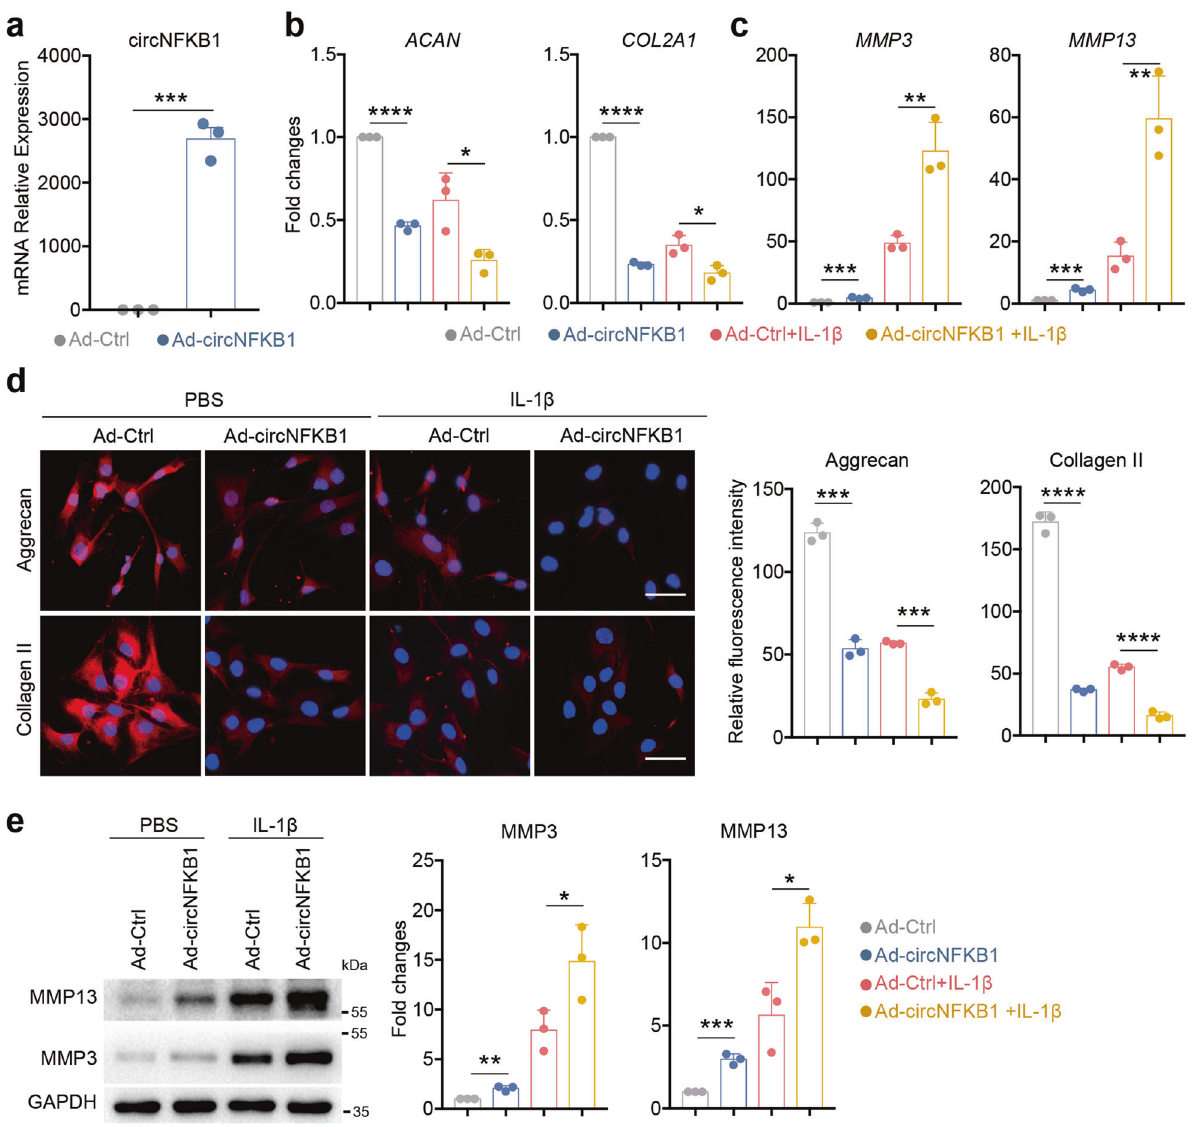
Fig. 4 Overexpression of circNFKB1 initiates ECM catabolism and promotes IL-1 β -induced chondrocytes degradation. a qRT-PCR analysis showing circNFKB1 RNA levels in circNFKB1 overexpressed HCs. b , c qRT-PCR analysis mRNA levels of ACAN , COL2A1 , MMP3, and MMP13 in circNFKB1 overexpressed HCs. d Representative immuno fl uorescence images and quantitative data of Aggrecan and Collagen II protein levels in chondrocytes after circNFKB1 overexpression. Scale bars, 25 μ m. e Western blotting analysis of MMP3 and MMP13 expression in circNFKB1 overexpressed chondrocytes. a – e , n = 3 biologically independent experiments, mean values ± SD are shown, and p values were calculated by two-tailed Student ’ s t test. * p < 0.05, ** p < 0.01, *** p < 0.001, **** p < 0.0001. d , e representative images are